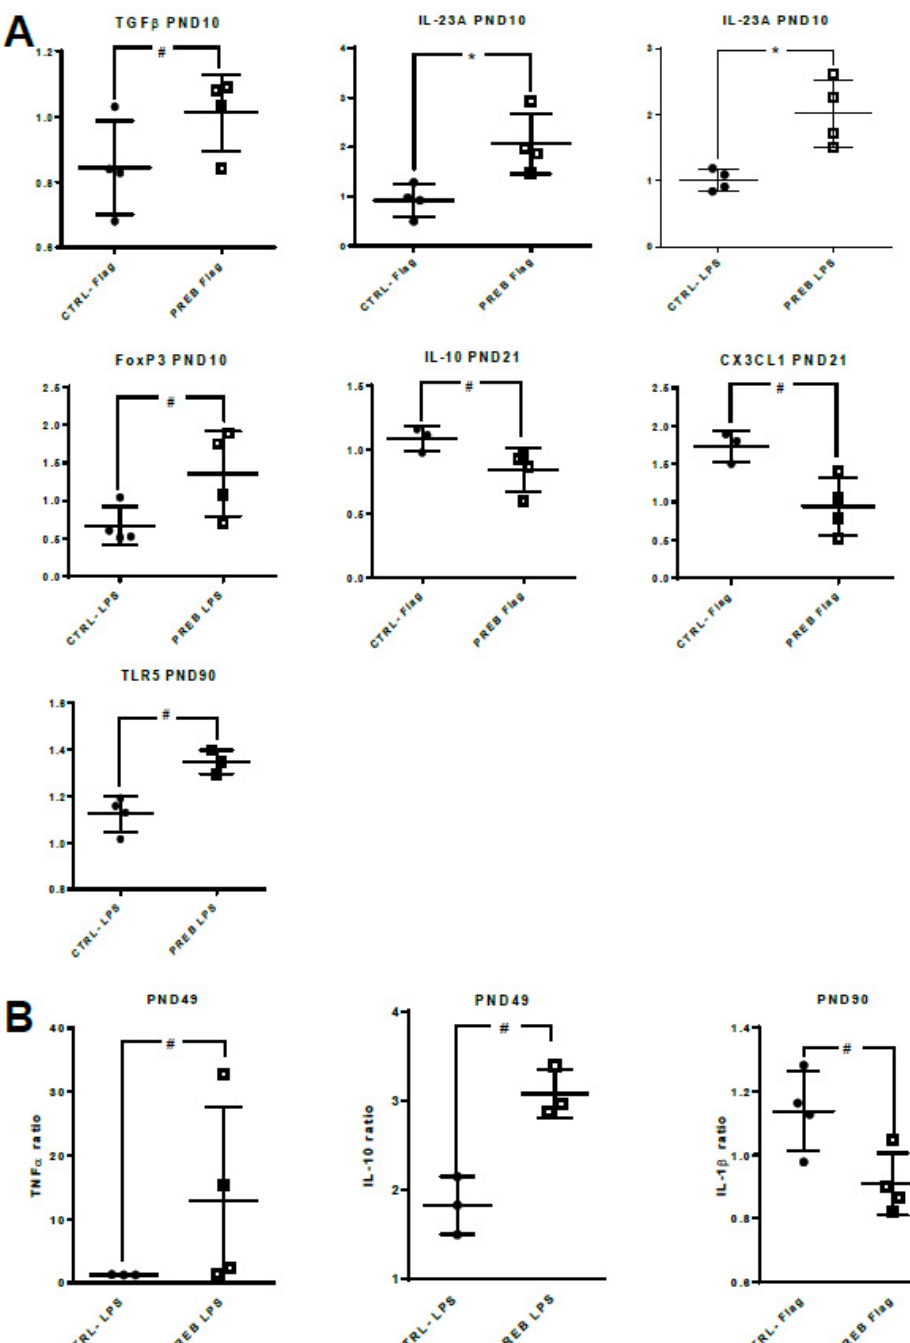
Figure 6. Sow diet prebiotic supplementation effect on gene expression and cytokine patterns of il ‐ PP explants stimulated with TLR ‐ ligands. Datasets were analyzed using the non ‐ parametric Mann ‐ Whitney test. ( A ) Relative expressions of the target genes were determined using the 2 −ΔΔ Ct method. Il ‐ PP explant gene expressions after stimulation with LPS (50 μ g/mL) or with flagellin (1 μ g/mL, Flag) between CTRL ‐ ( n = 3–4, full circle) and PREB ( n = 3–4, empty square) piglets (* p < 0.05, # p < 0.10). ( B ) Il ‐ PP explant cytokine secretion following TLR ‐ ligand stimulation between CTRL ‐ ( n = 3–4, full circle) and PREB ( n = 3–4, empty square) (# p < 0.10).